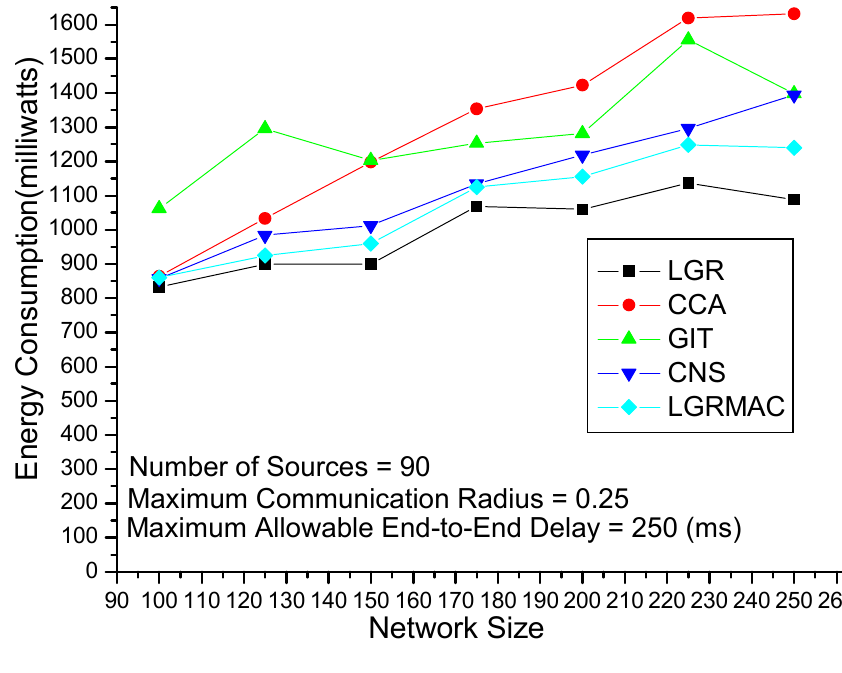
Figure 6. Performance comparison with respect to network sizes.